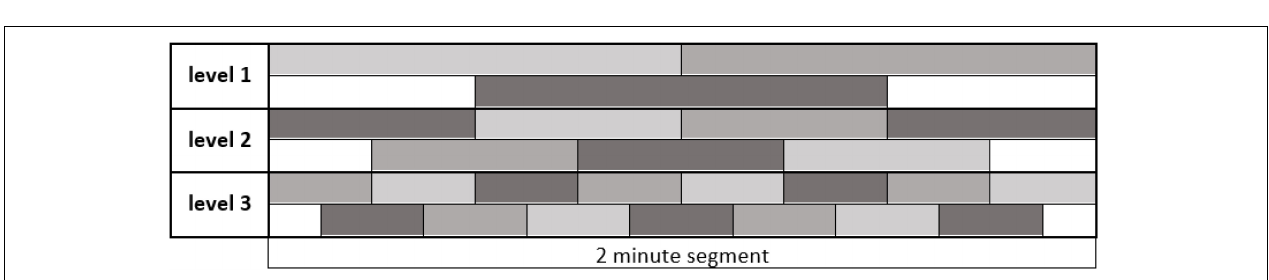
FIGURE 3 | Dividing a 2 min segment of the original 24h time series into shapelets. The length of the entire interval in figure is 2 min, as indicated. Each level contains equally sized adjacent shapelets without overlapping. The original set of shapelets is illustrated as the top sequence at each level. Additional set of shapelets obtained by shifting by half shapelet length is illustrated as bottom sequence at each level. For clarity, shapelets show different shades of gray. In later computations we consider all these shapelets equally, no matter to which level they belong. We call ‘pool of shapelets’ this entire ensemble of shapelets cumulatively.